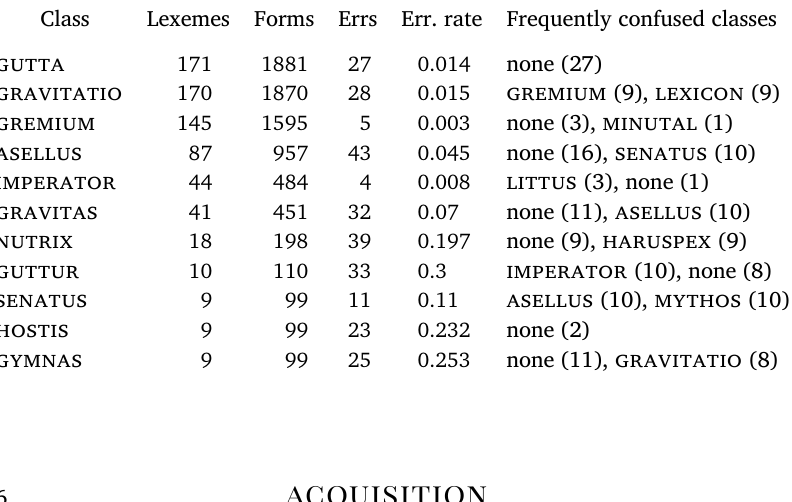
Table 5: Errors for common